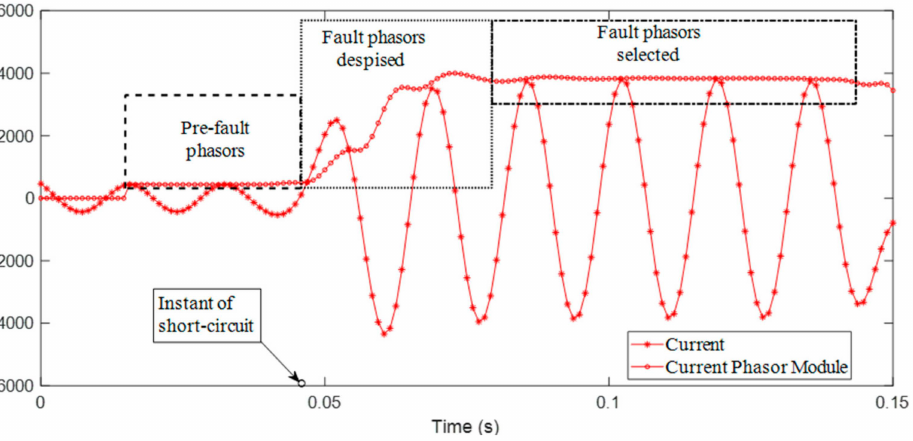
Figure 8. Detail of selection of phasors from the missing phase A current signal, after low-pass filtering.